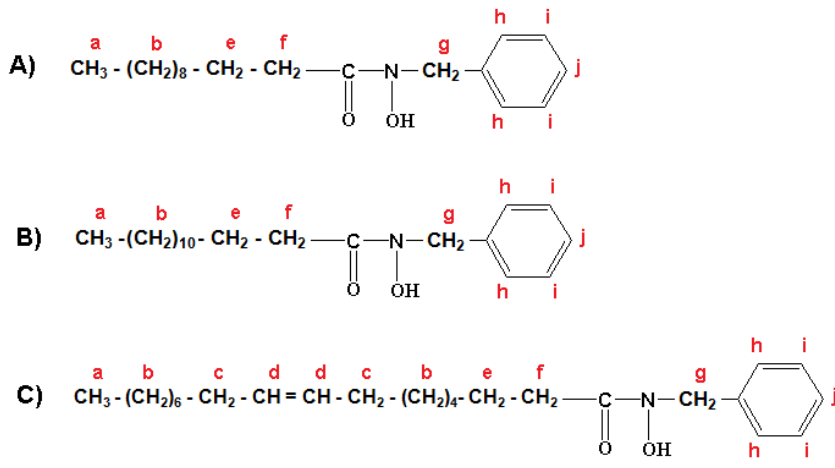
Figure 5. Formulation of benzyl laureo hydroxamic acid (A); benzyl myristo hydroxamic acid (B); benzyl oleo hydroxamic acid